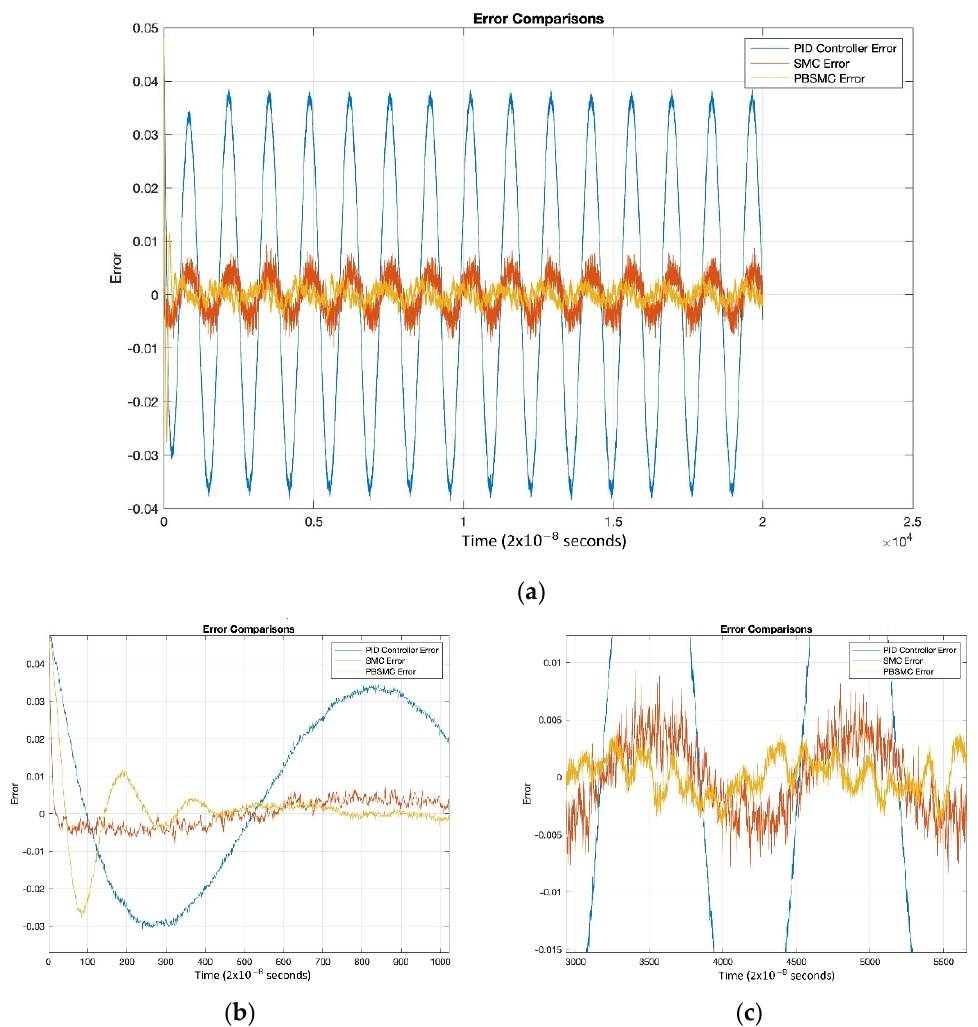
Figure 12. ( a ) Experimental Controller Error Performance Comparison, ( b ) Convergence Performance, ( c ) Steady-State Error Performance. Table 9. Error Performance and Convergence Time Comparison for Experimental Data.